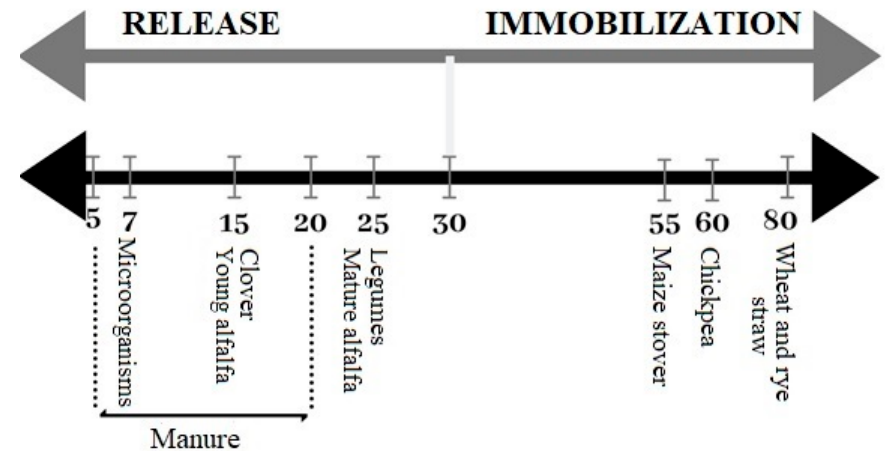
Figure 2. The carbon-to-nitrogen ratio (C:N) ratio of selected plants. Compiled by the Author.